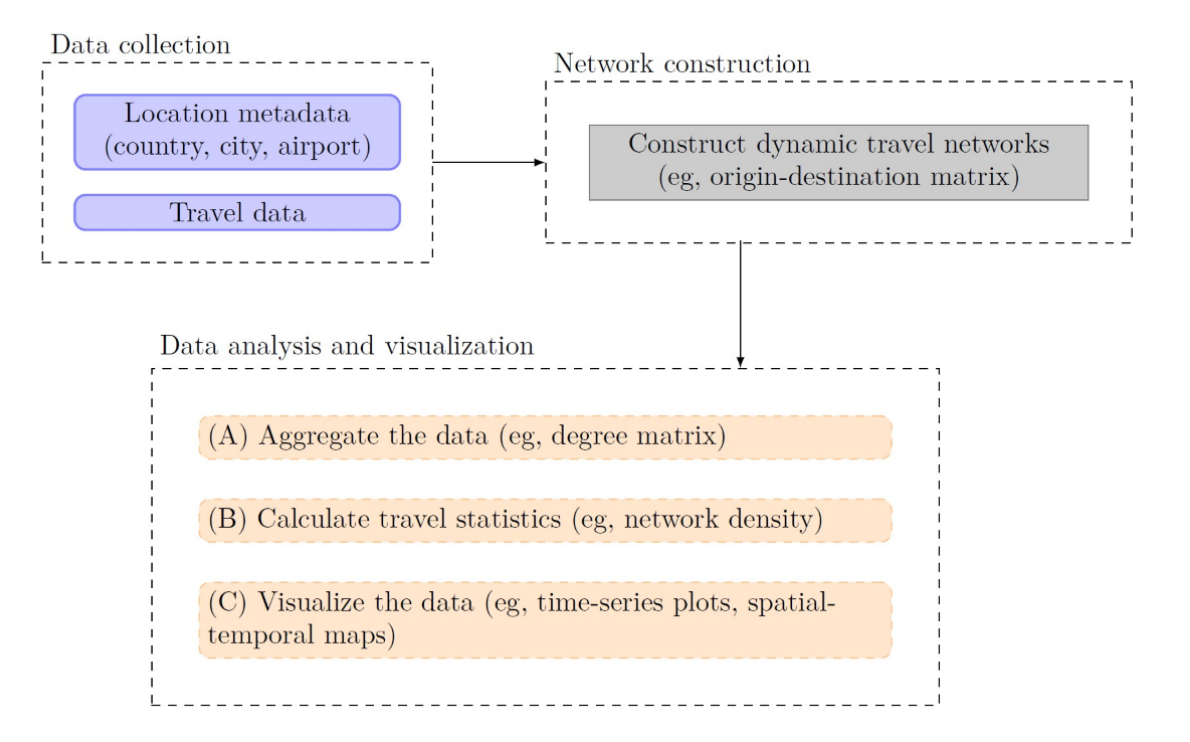
Figure 1. Workflow of data collection and